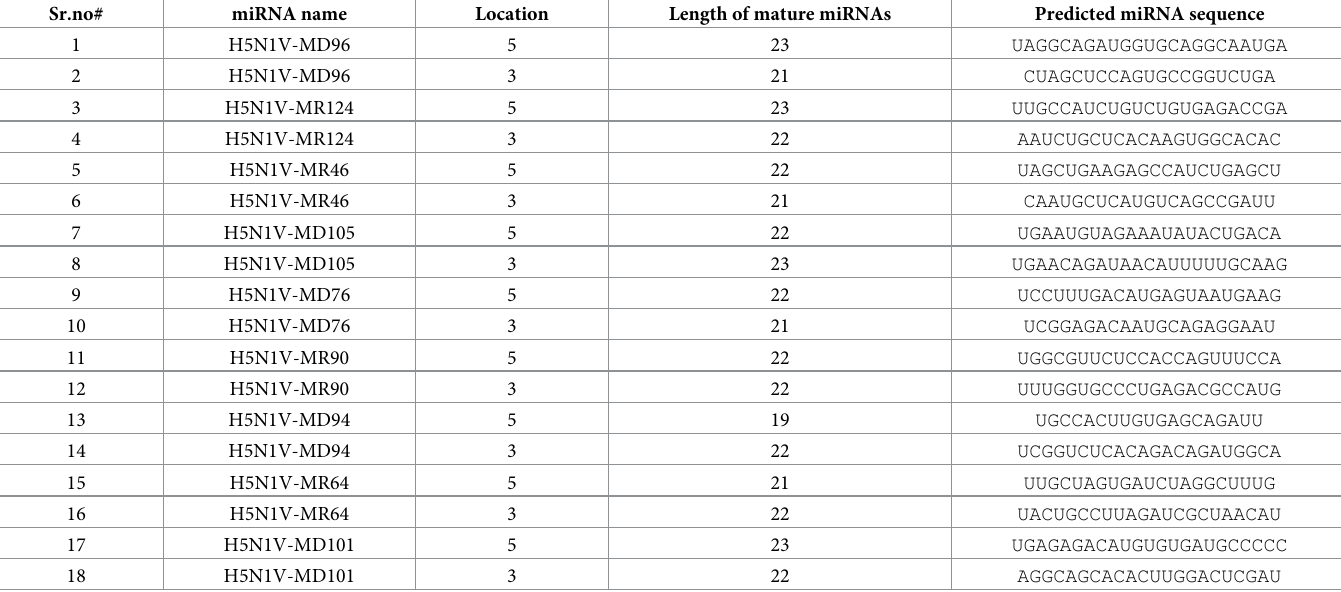
Table 2. Length, location and predicted miRNAs sequence of RSN mature